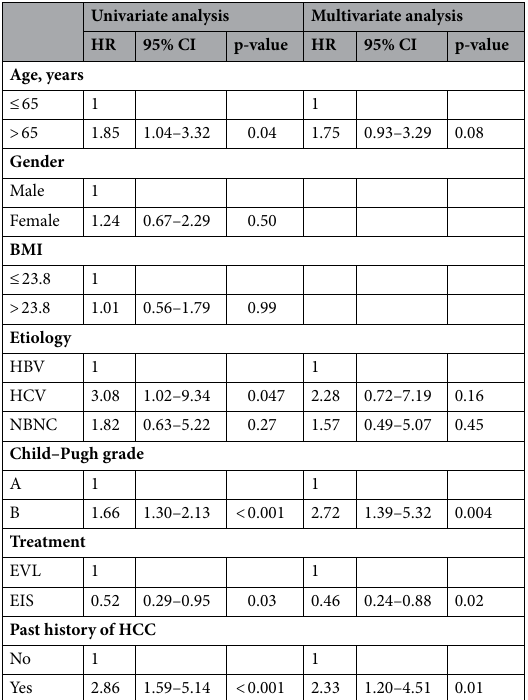
Table 2. Cox regression analysis about baseline factors associated with all-cause death in all patients. BMI body mass index, CI confidence interval, EIS endoscopic injection sclerotherapy, HBV hepatitis B virus, HCC